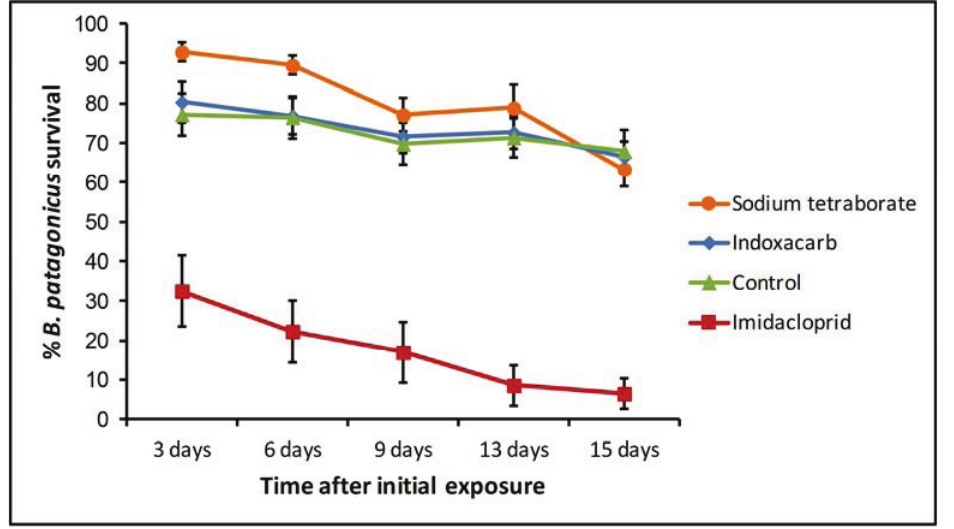
Figure 3. Changes in the mean percent B. patagonicus survival over time during their exposure to different bait treatments. Error bars were constructed with the standard error of the mean.